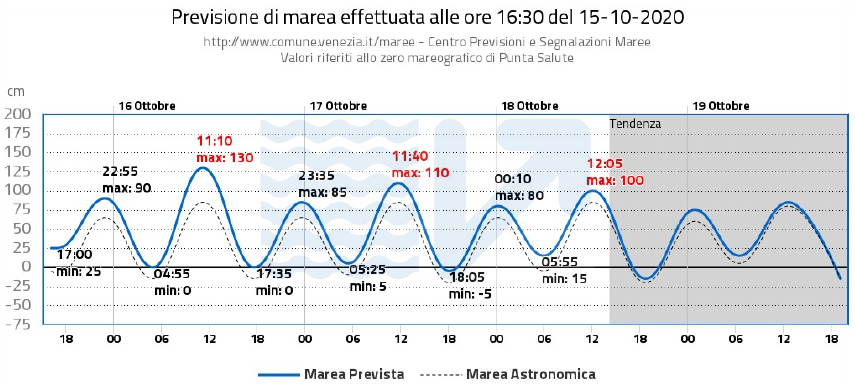
Figure 5. An example of the daily bulletin published on the official forecasts website of CPSM – Venice Municipality. The chart shows a 4d forecast plus 1d forecast trend. The water level refers to the Punta Salute datum, the historical zero of Venice defined in the year 1897. The blue line is the total expected sea level, and the dotted black line indicates the astronomical